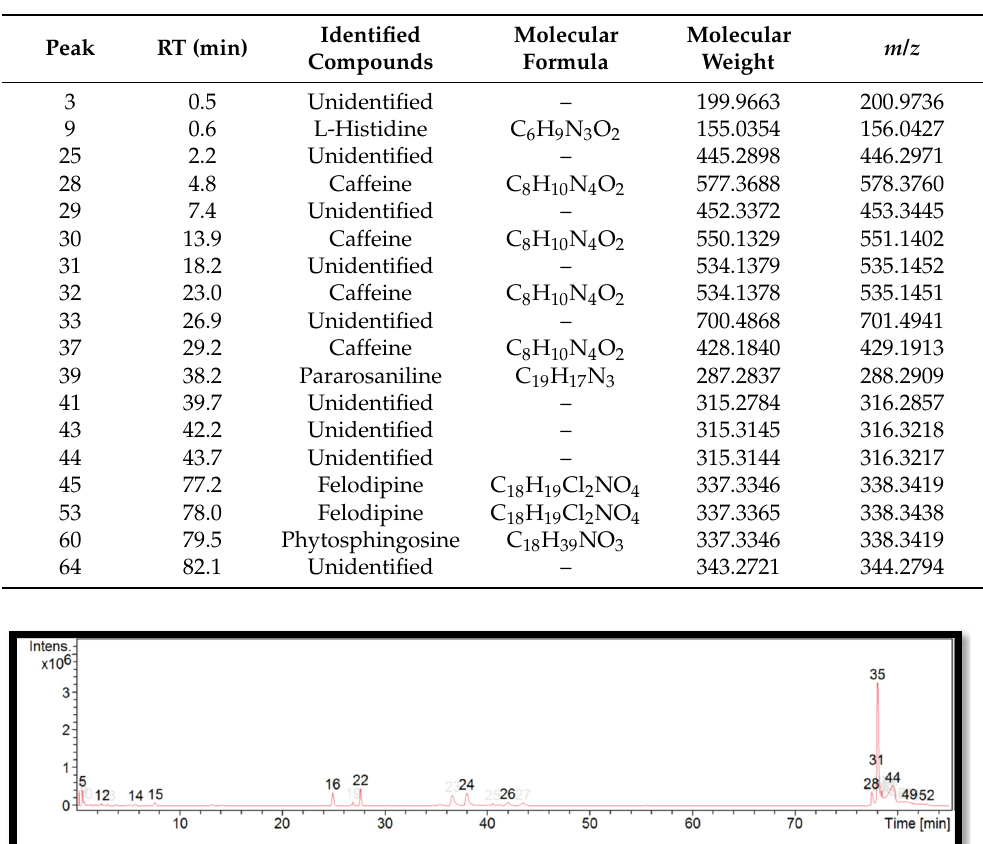
Table 5. The compounds identified in B. multiplex .